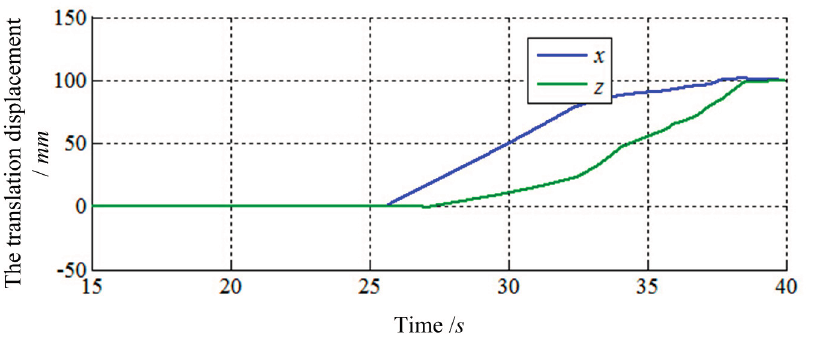
Figure 22. The translation displacement of load sensing ring based on Equation (12).